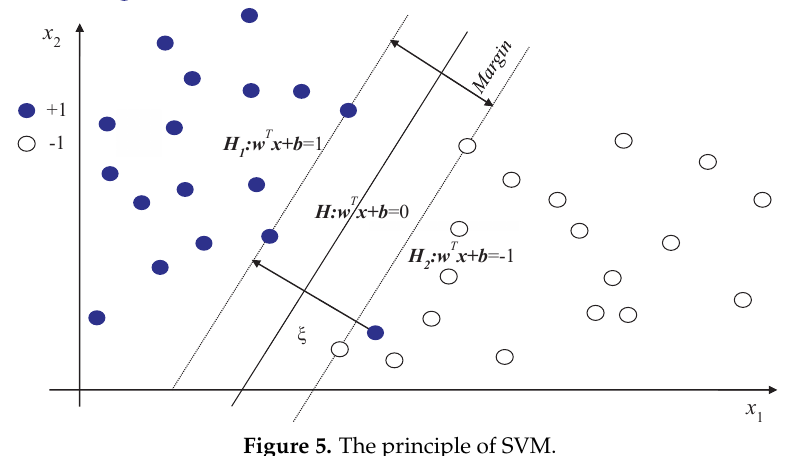
Figure 5. The principle of